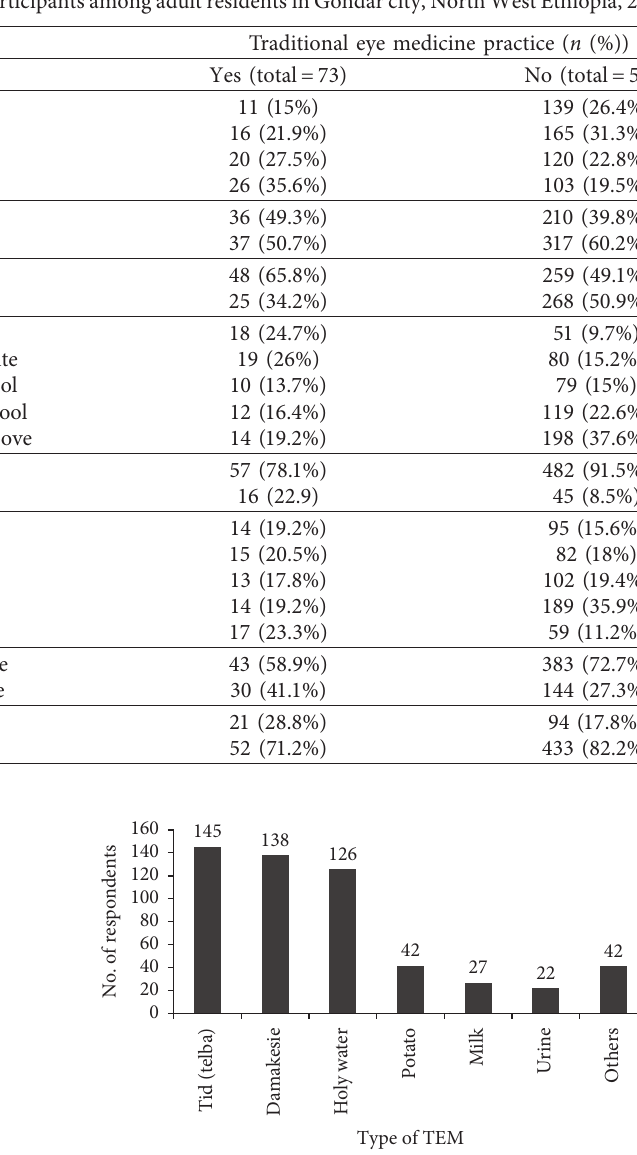
Figure 3: Bar graph that shows types of traditional eye medicine most commonly known by study participants among adult resi- dents in Gondar city, North West Ethiopia,